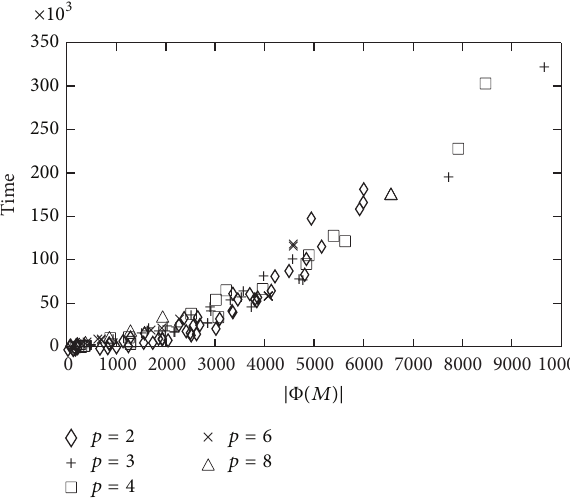
Figure 4: |Φ(𝑀)| versus execution time (in ms) of non-PA when 𝑝 > 1 .